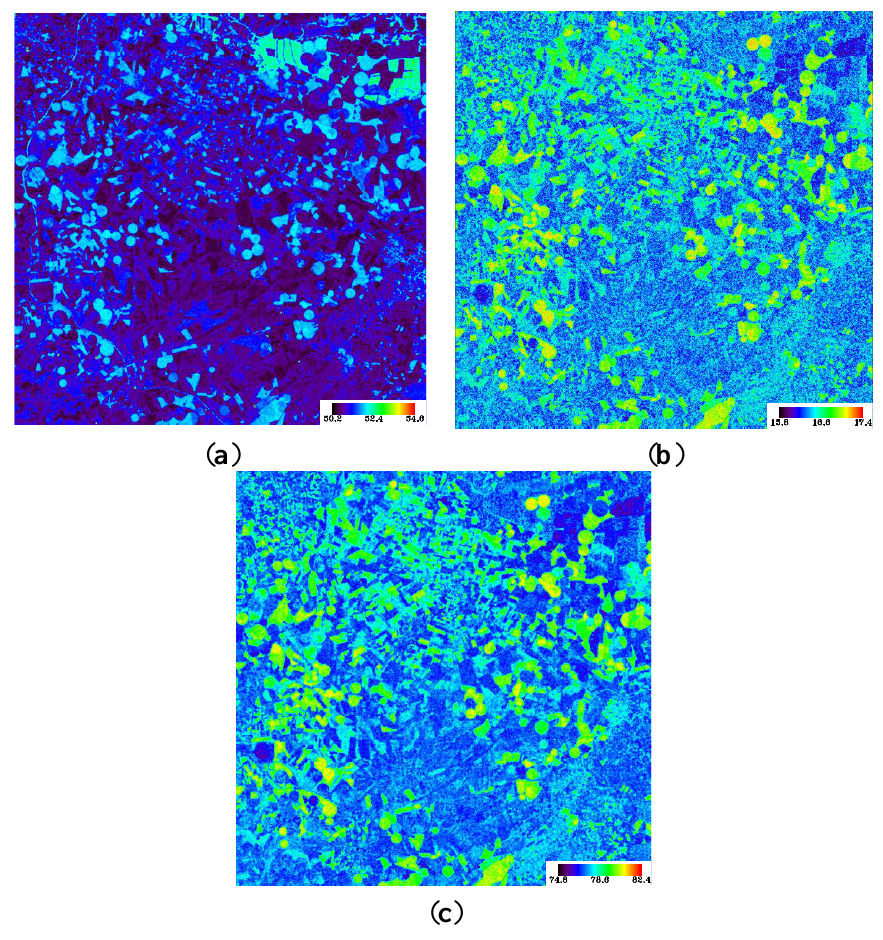
Figure 17. Standard deviation calculated over all WV maps; ( a , top-left) radiometric scenario; ( b , top-right) 0.5 nm shift scenario; ( c , bottom-left) 2 nm shift scenario. Note that the data range and thus the colour coding is different for each